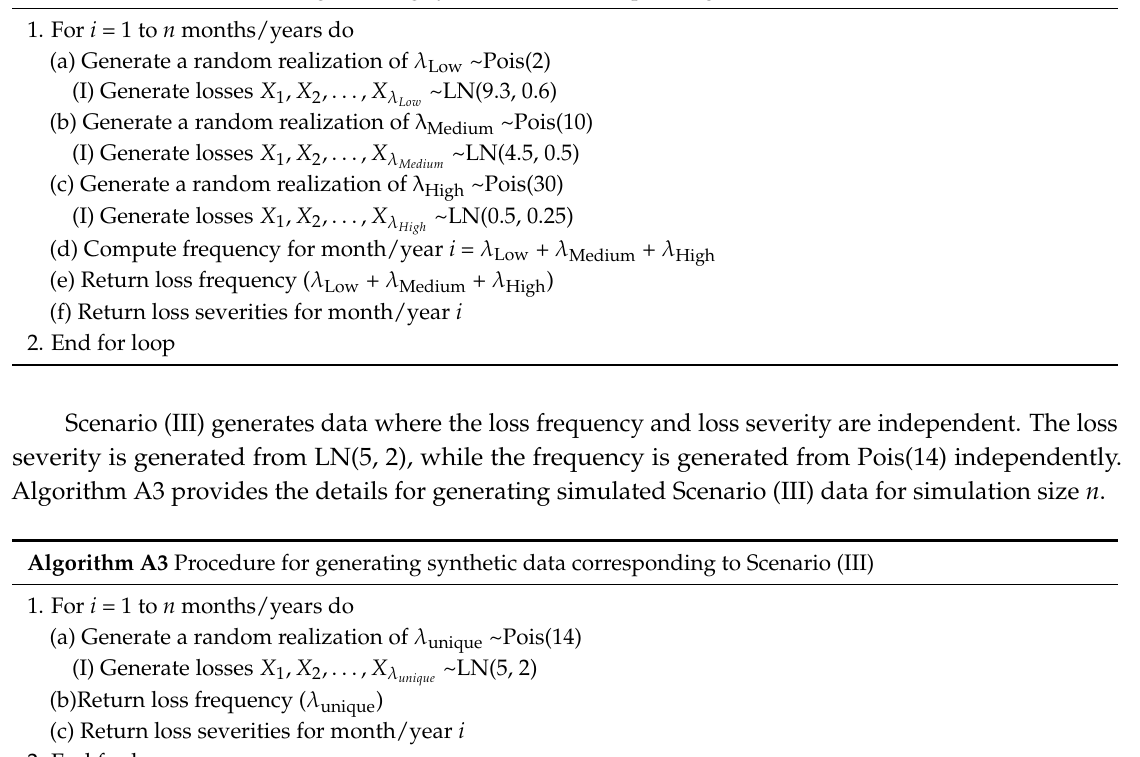
Algorithm A2 Procedure for generating synthetic data corresponding to Scenario (II) 1. For i = 1 to n months/years do